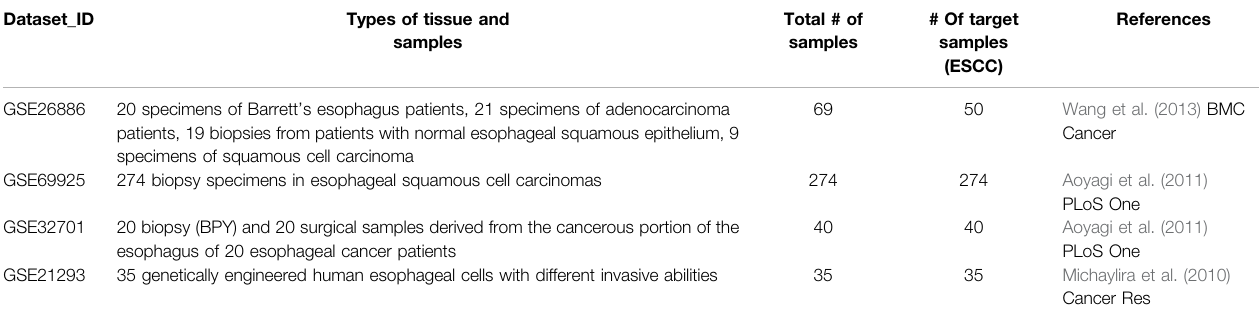
TABLE 1 | Clinical characteristics of metabolic syndrome-related